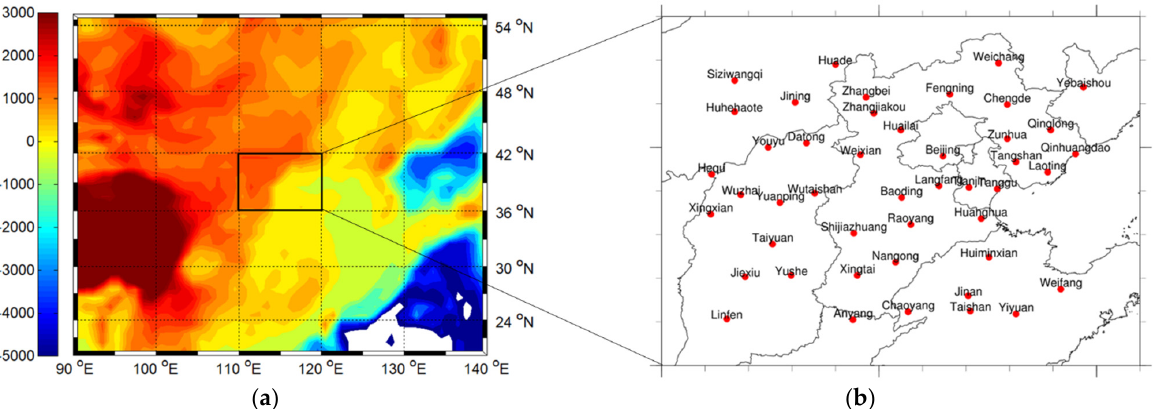
Figure 1. Study area and station distribution: ( a ) Topography of the study area (m), ( b ) distribution of stations. of